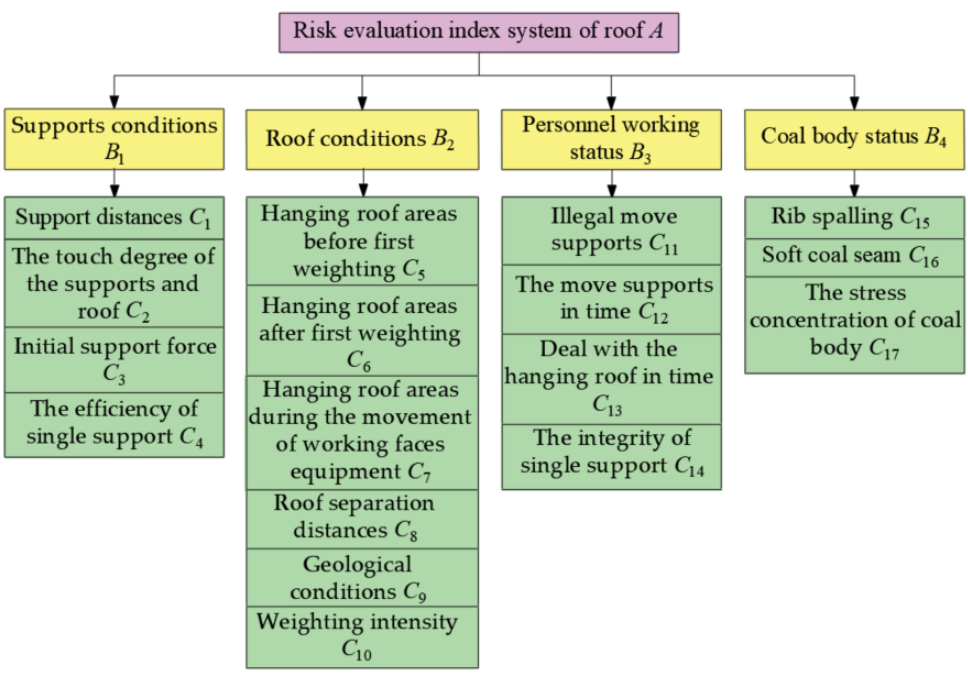
Figure 1. Risk evaluation index system of roof accidents in working faces. Table 3. Risk evaluation grade standard of roof